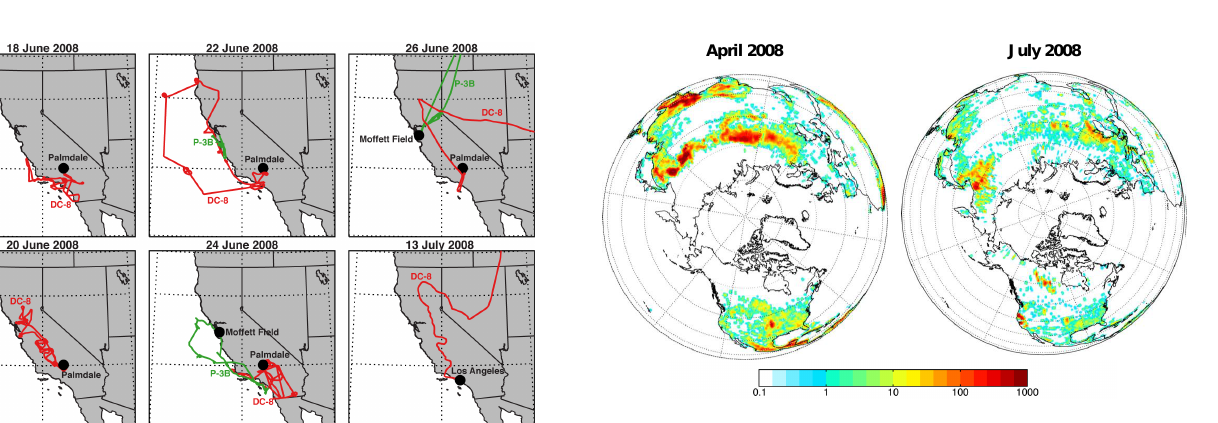
Figure 2. Monthly fire counts for April and July 2008 from the MODIS Aqua satellite Fig. 2. Monthly fire counts for April and July 2008 from the instrument (1330 local overpass time), cloud- and overpass-corrected (V5, available from MODIS Aqua satellite instrument (13:30 local overpass time), http://neespi.gsfc.nasa.gov/myd14cm1.shtml) cloud- and overpass-corrected (V5, available from http://neespi.